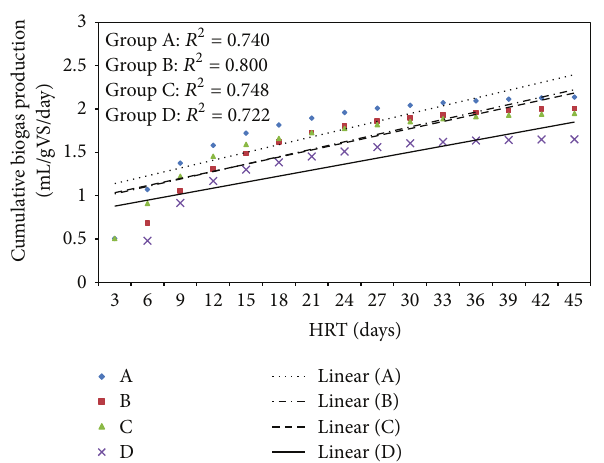
Figure 11: Exponential rise to maximum plot for cumulative biogas production of all the groups